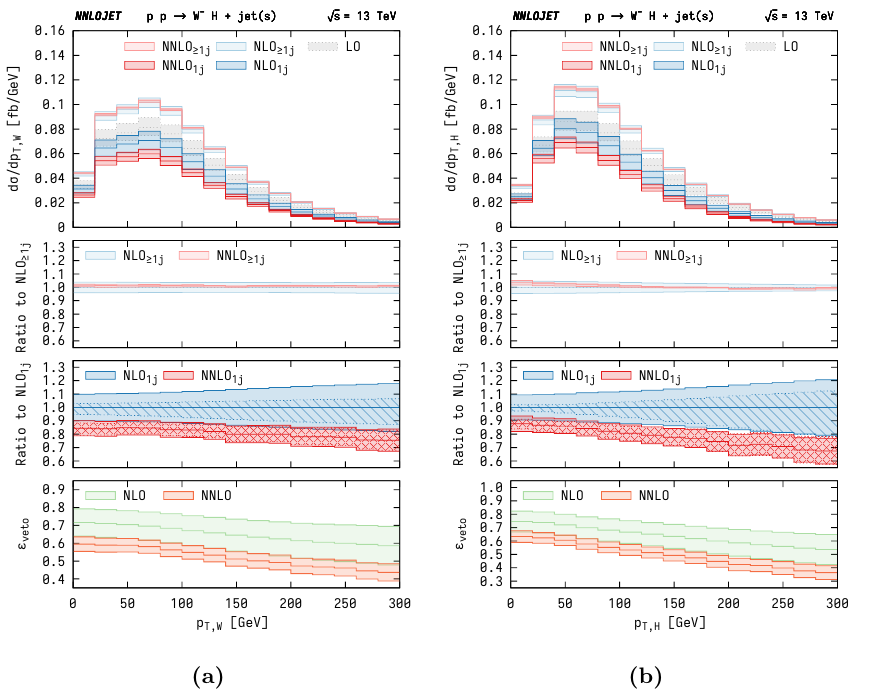
Figure 2. Transverse momentum distribution of (a) the gauge boson and (b) the Higgs boson for the W − H + jet